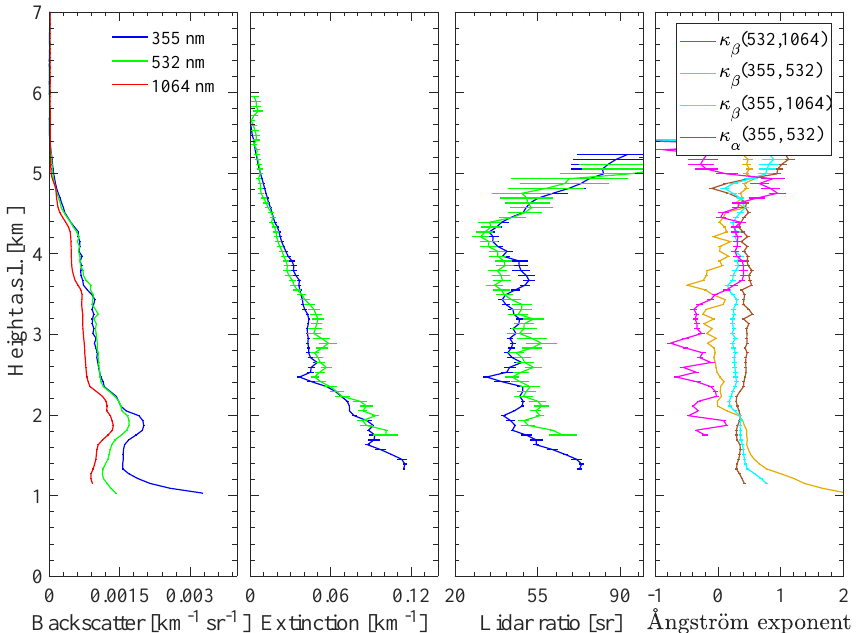
Figure 2. Optical profiles measured in Potenza on 14 July 2011, 19:20–22:10UTC, with a multi-wavelength Raman lidar. The error bars correspond to the standard